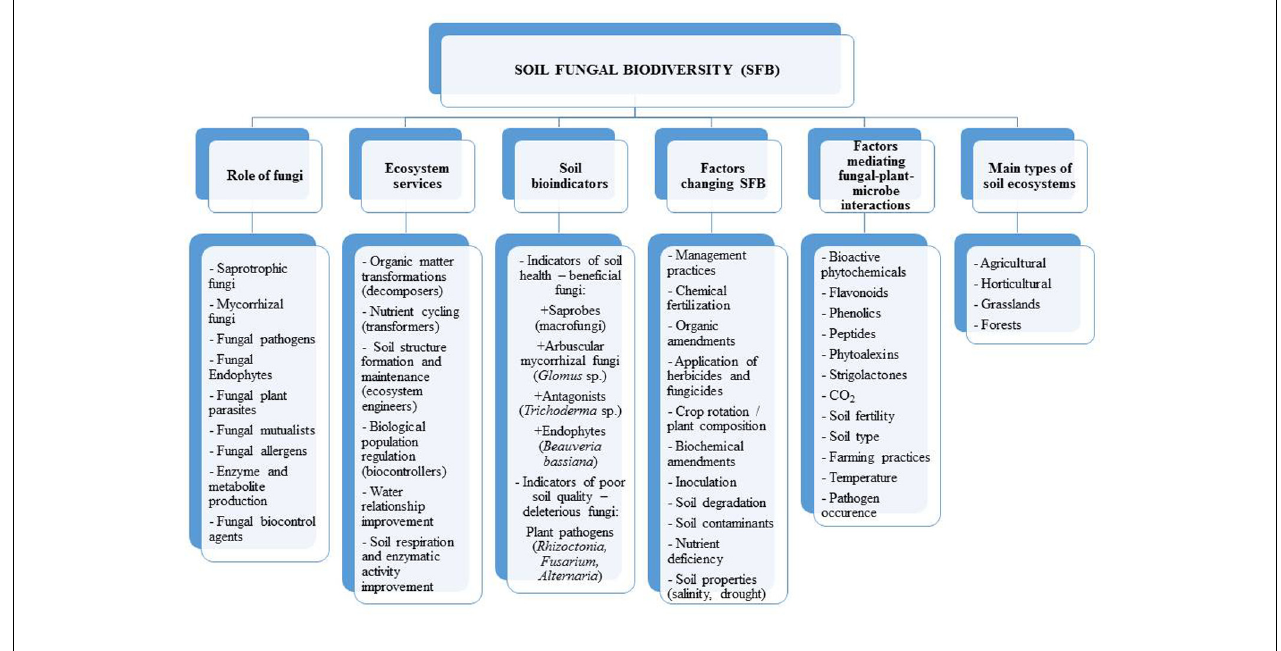
FIGURE 1 | Aspects of soil fungal biodiversity.